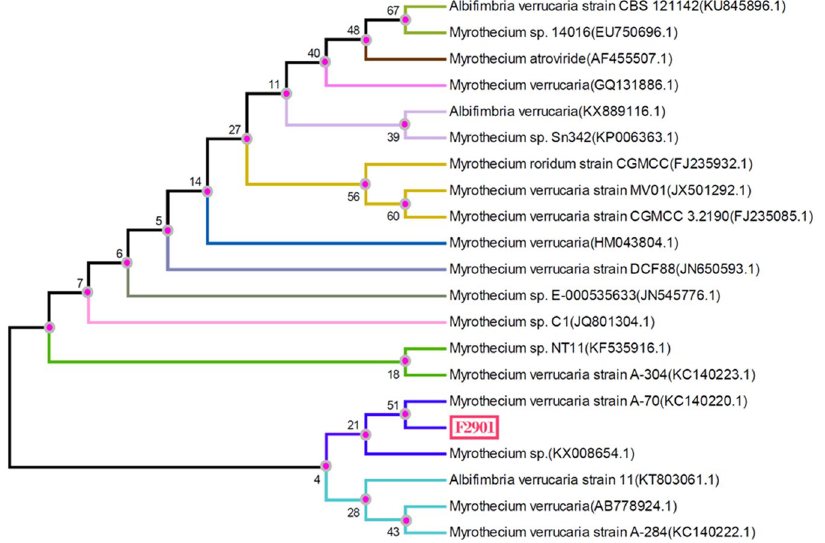
Figure 4. Phylogenetic tree analysis of M . V